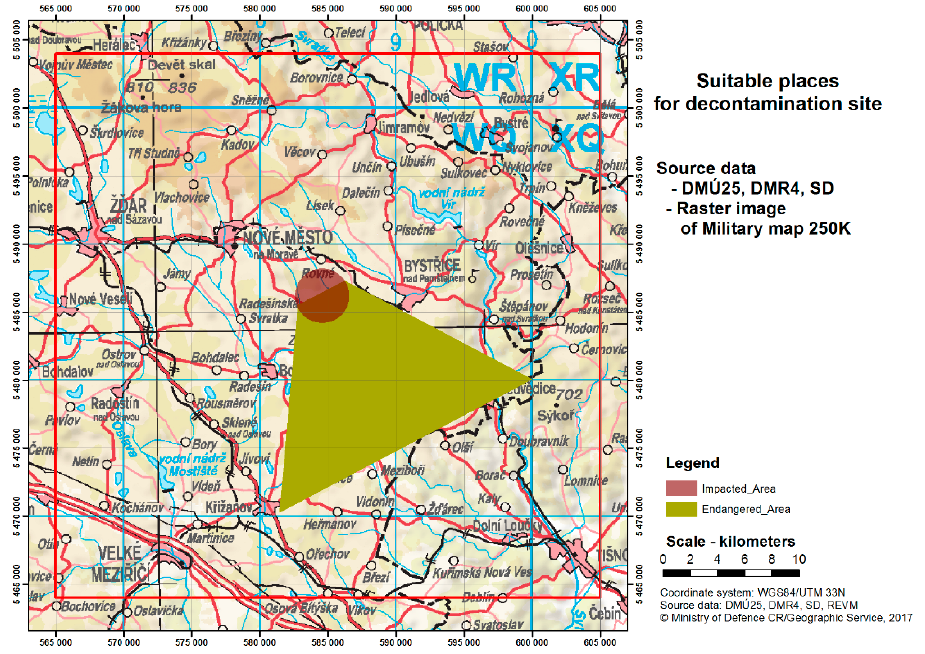
Figure 2. Area of responsibility (modelled example).